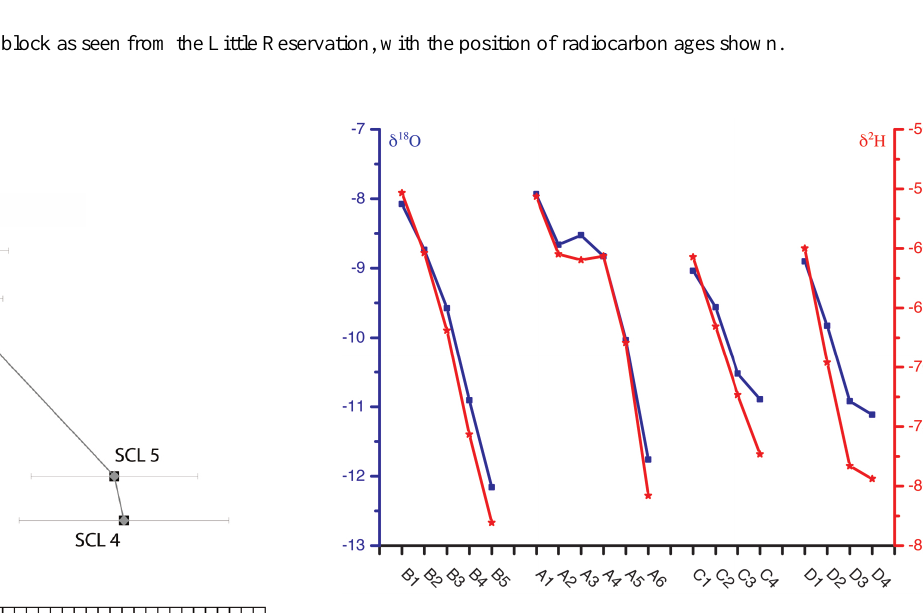
Fig. 5. δ 18 O (blue line and left axis) and δ 2 H (red line and right axis) profiles in the ice cores (A drilled in 2009, B drilled in 2005, C is ice from the LIA and D is ice from the MWP) drilled on top of the ice block in Sc˘aris¸oara Ice